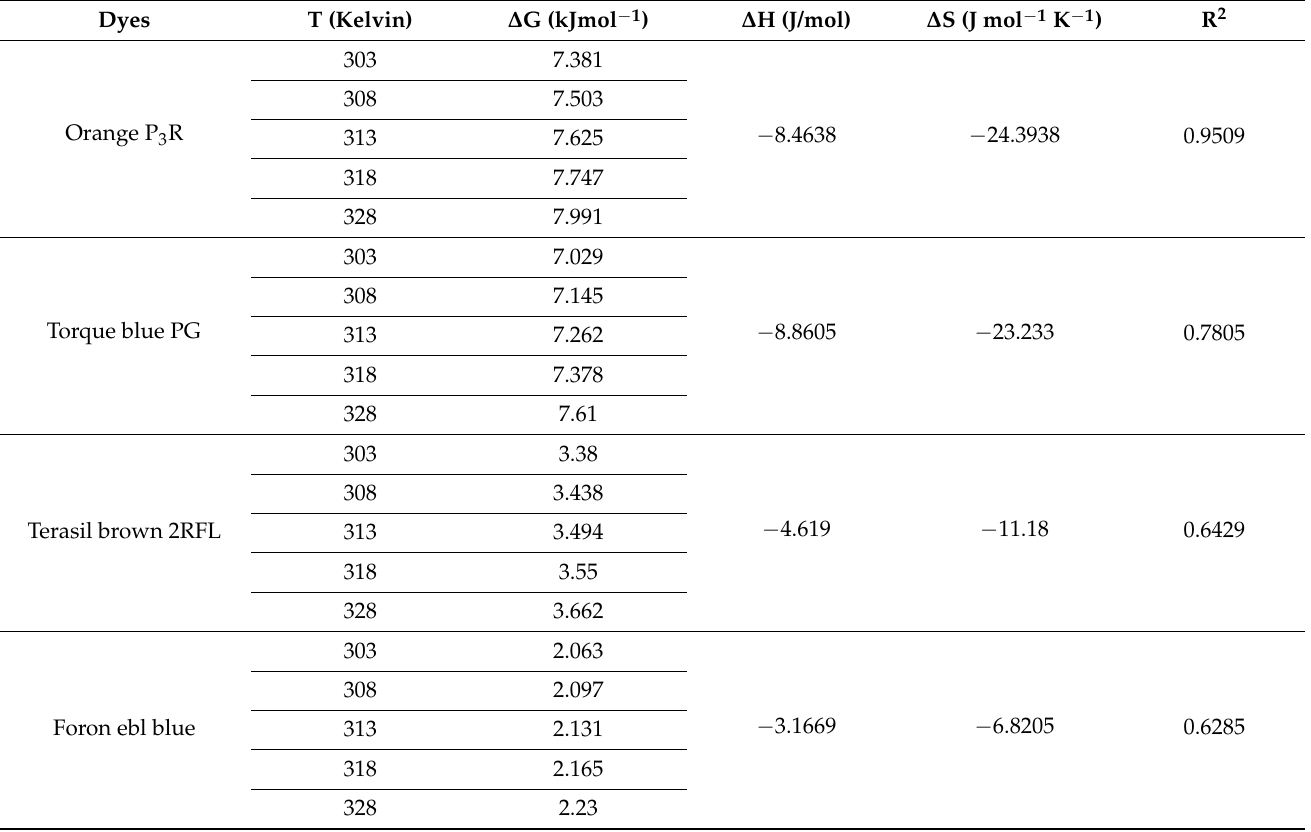
Table 5. Enthalpy change ( ∆ H), Entropy change ( ∆ S), and Gibbs free energy ( ∆ G) for 4 dyes with non-calcinized composite.